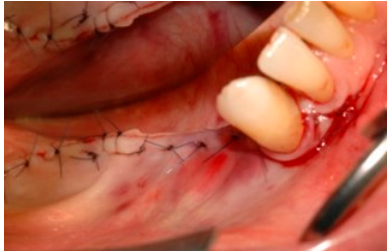
Figure 8. After checking the absence of any residual tension, the flap was sutured with nonresorbable suturing stitches.